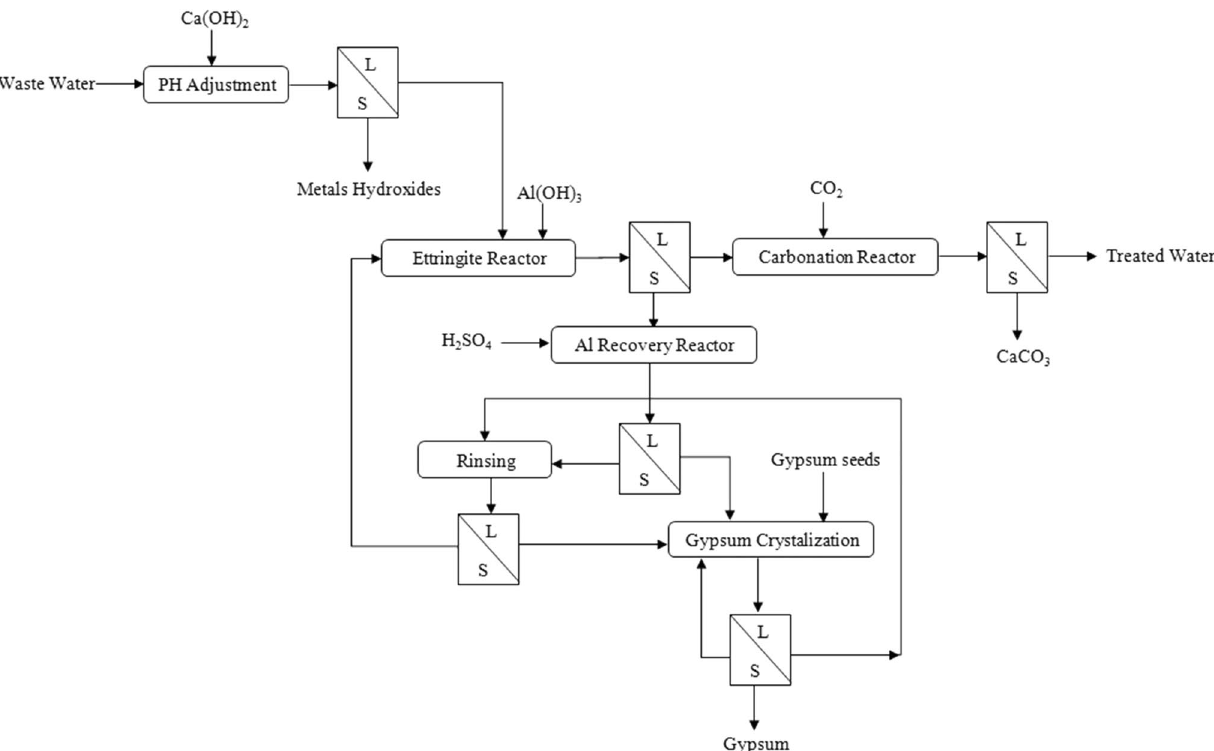
Fig. 1 Flow diagram of the sulfate removal by ettringite precipitation